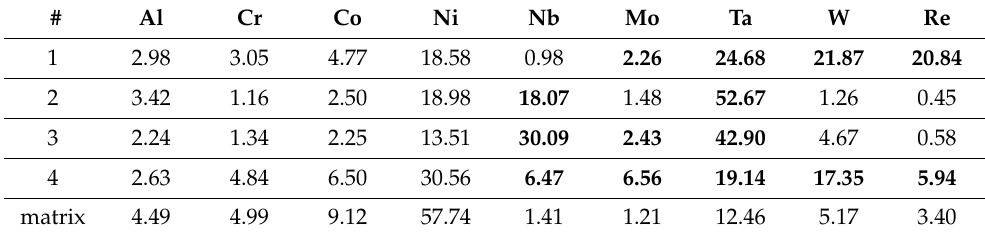
Figure 14. STEM images of grain boundary segregations in thin walls obtained at low heat input ( a ) and high heat input ( b ). Table 4. Quantitative composition of